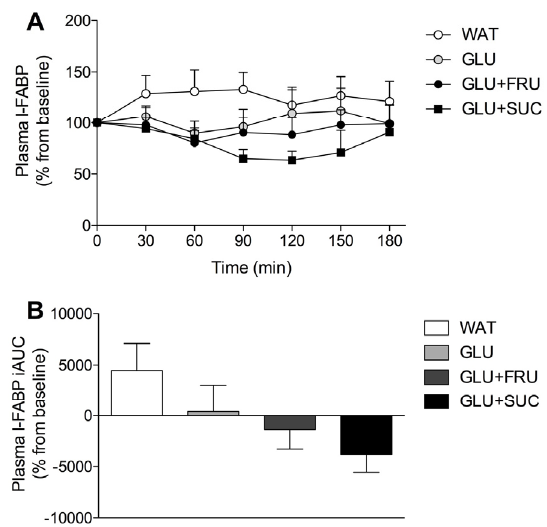
Figure 4. Plasma I-FABP concentrations during exercise ( A ) and (area under the curve (AUC) of percentage I-FABP change during exercise ( B ) without ingestion of carbohydrate (WAT), with the ingestion of glucose (GLU), with the ingestion of glucose and fructose (GLU + FRU), or with the ingestion of glucose and sucrose (GLU + SUC). Plasma I-FABP (A) was analsysed with a two-way repeated measures ANOVA (time-treatment). Plasma I-FABP iAUC was analysed with a repeated measures ANOVA (treatment). Data are presented as means ± SEM. N = 10. Differences between treatments did not reach statistical significance ( p > 0.05).